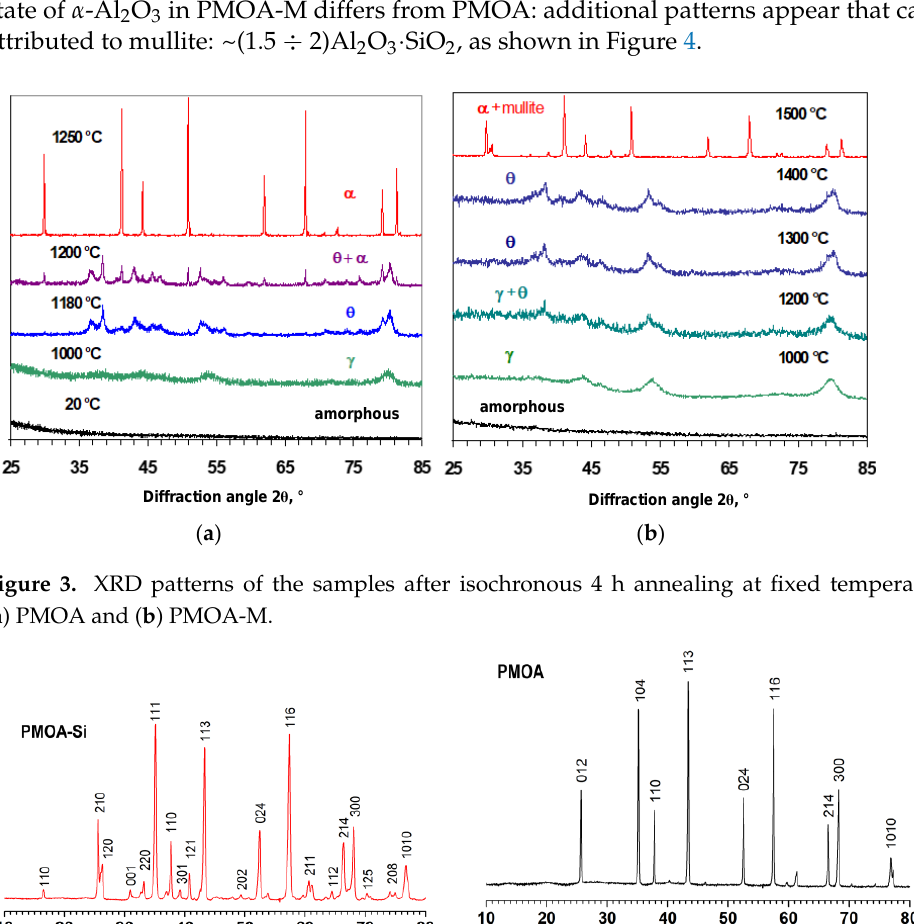
Table 3. Temperatures of phase transitions and the transition temperature shift after isochronous 4 h annealing of PMOA and PMOA-M nanomaterials. Figure 4. X-ray diffraction patterns of PMOA-M ( a ) and PMOA ( b ) samples after sintering at 1400 °C for 4 h.